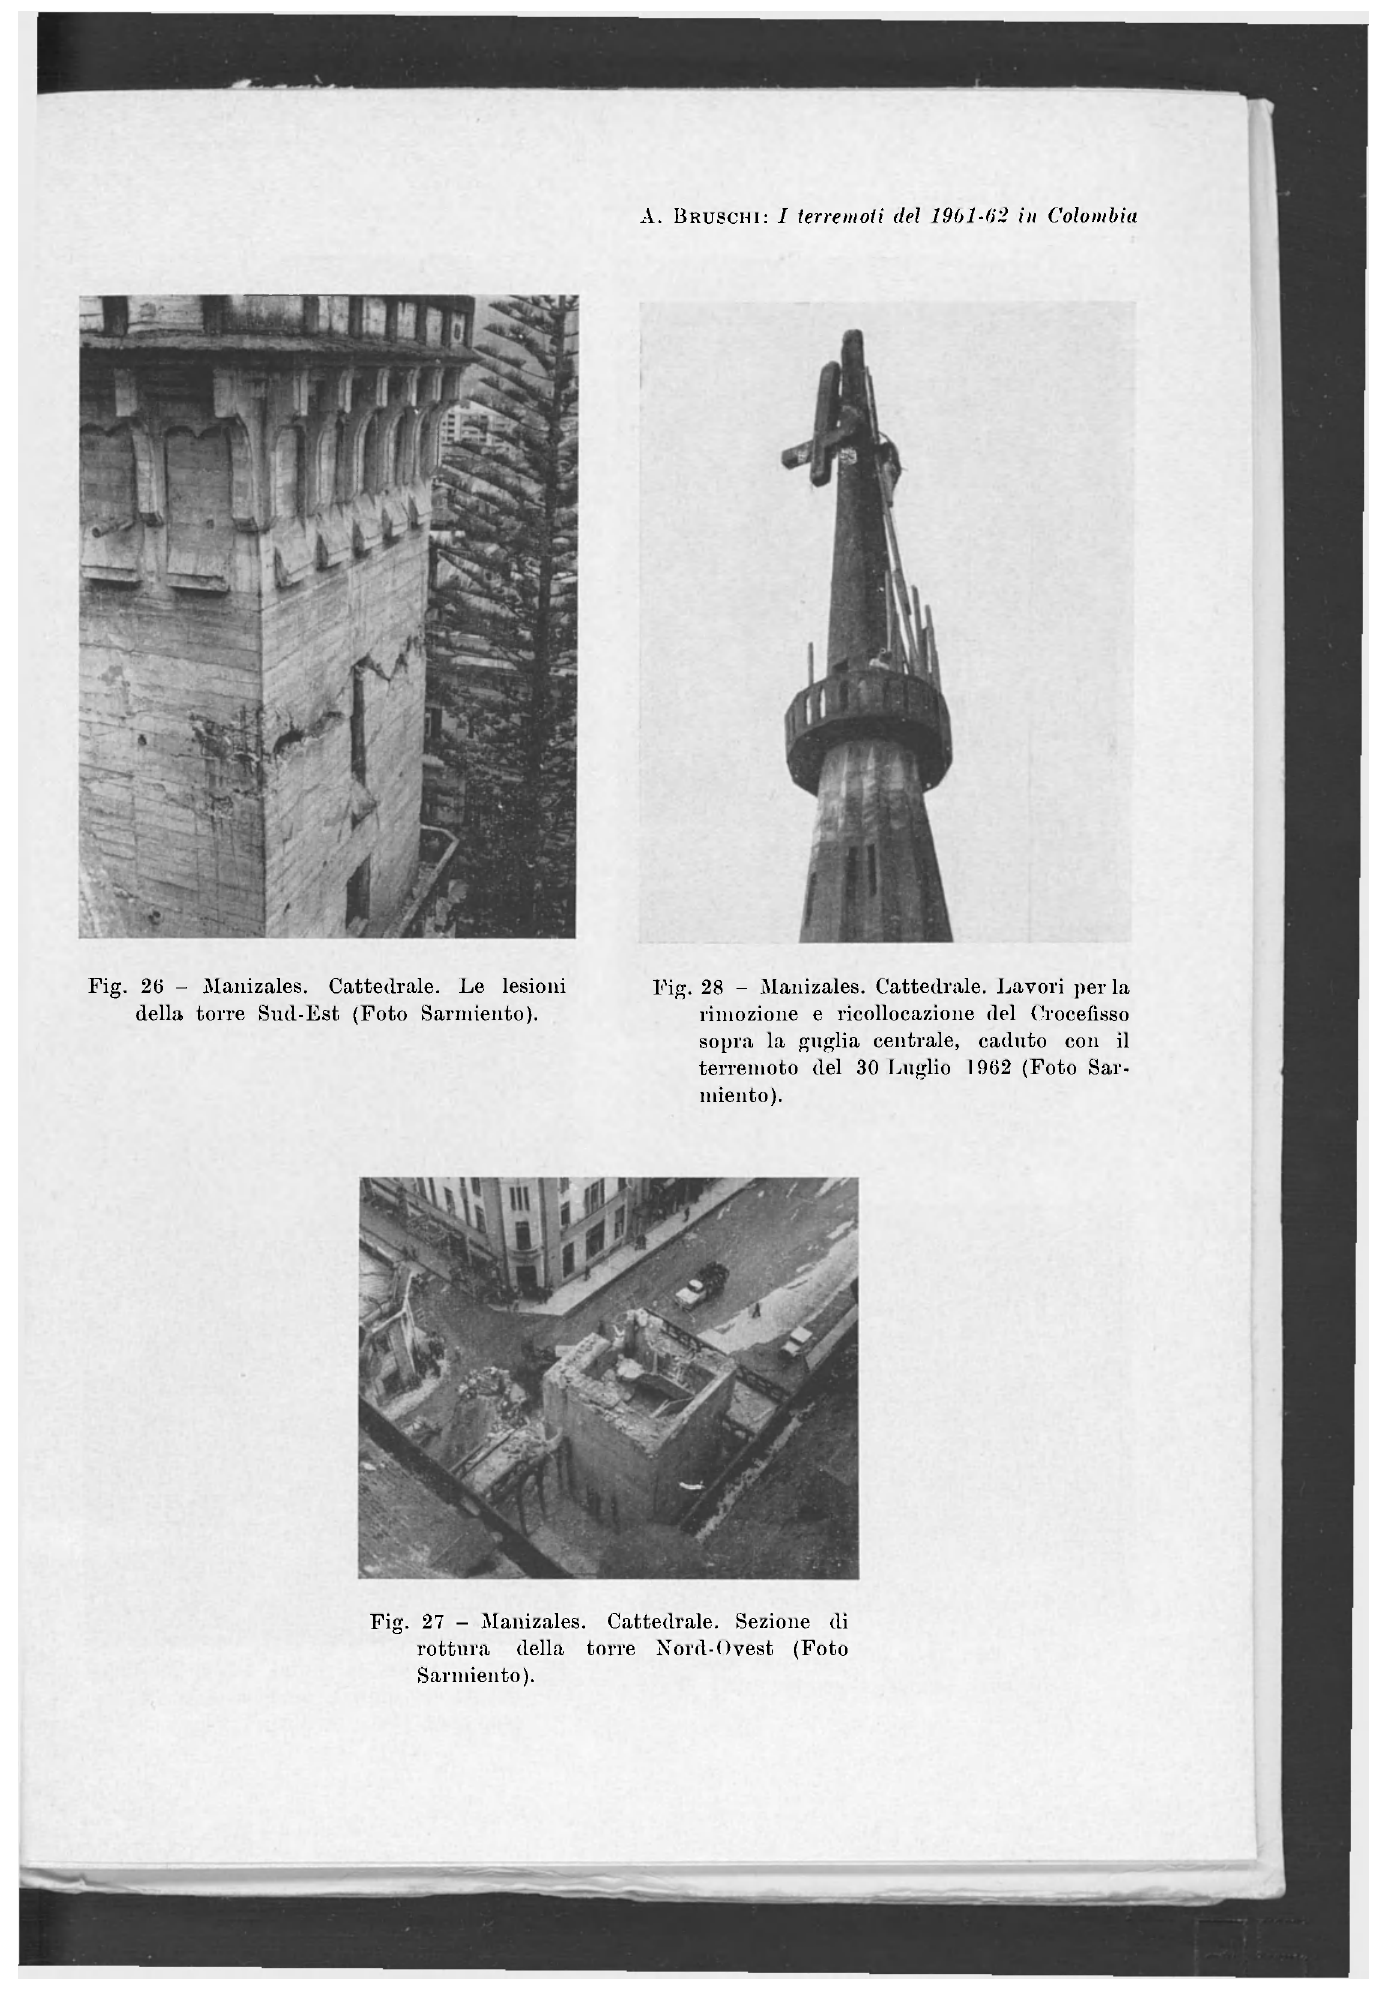
Fig. 27 - Manizales.